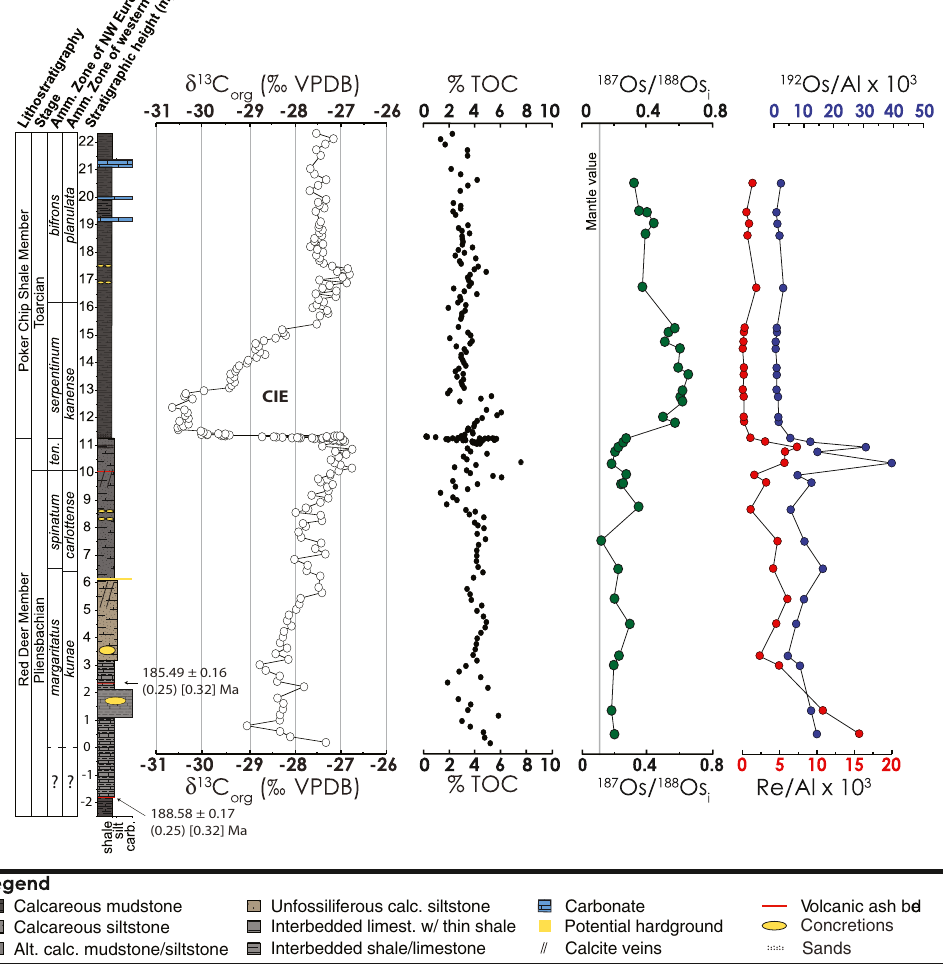
Figure 3. Chemostratigraphy of the Lower Jurassic Fernie Formation from East Tributary of Bighorn Creek, Alberta. δ 13 C org = organic carbon isotopic compositions from ref. 15. 187 Os/ 188 Os i = initial osmium isotopic composition of organic-rich sediments. Lithostratigraphic members of the Fernie Formation, Stages of the Jurassic, and ammonite zonations for both northwestern Europe and western North American shown to the left of the stratigraphic column (refer to ref. 15 for the details of their placements). Vertical gray line in 187 Os/ 188 Os i record is the end-member 187 Os/ 188 Os m value of ~0.12. We report new single zircon U-Pb CA-ID-TIMS ages of 188.58 ± 0.17 (0.25) [0.32] Ma in the bentonite at − 1.9 meters and 185.49 ± 0.16 (0.25) [0.32] Ma in the bentonite at 2.35 meters, located in the margaritatus Zone of NW Europe or the kunae Zone of western NA (see Methods and SI Data